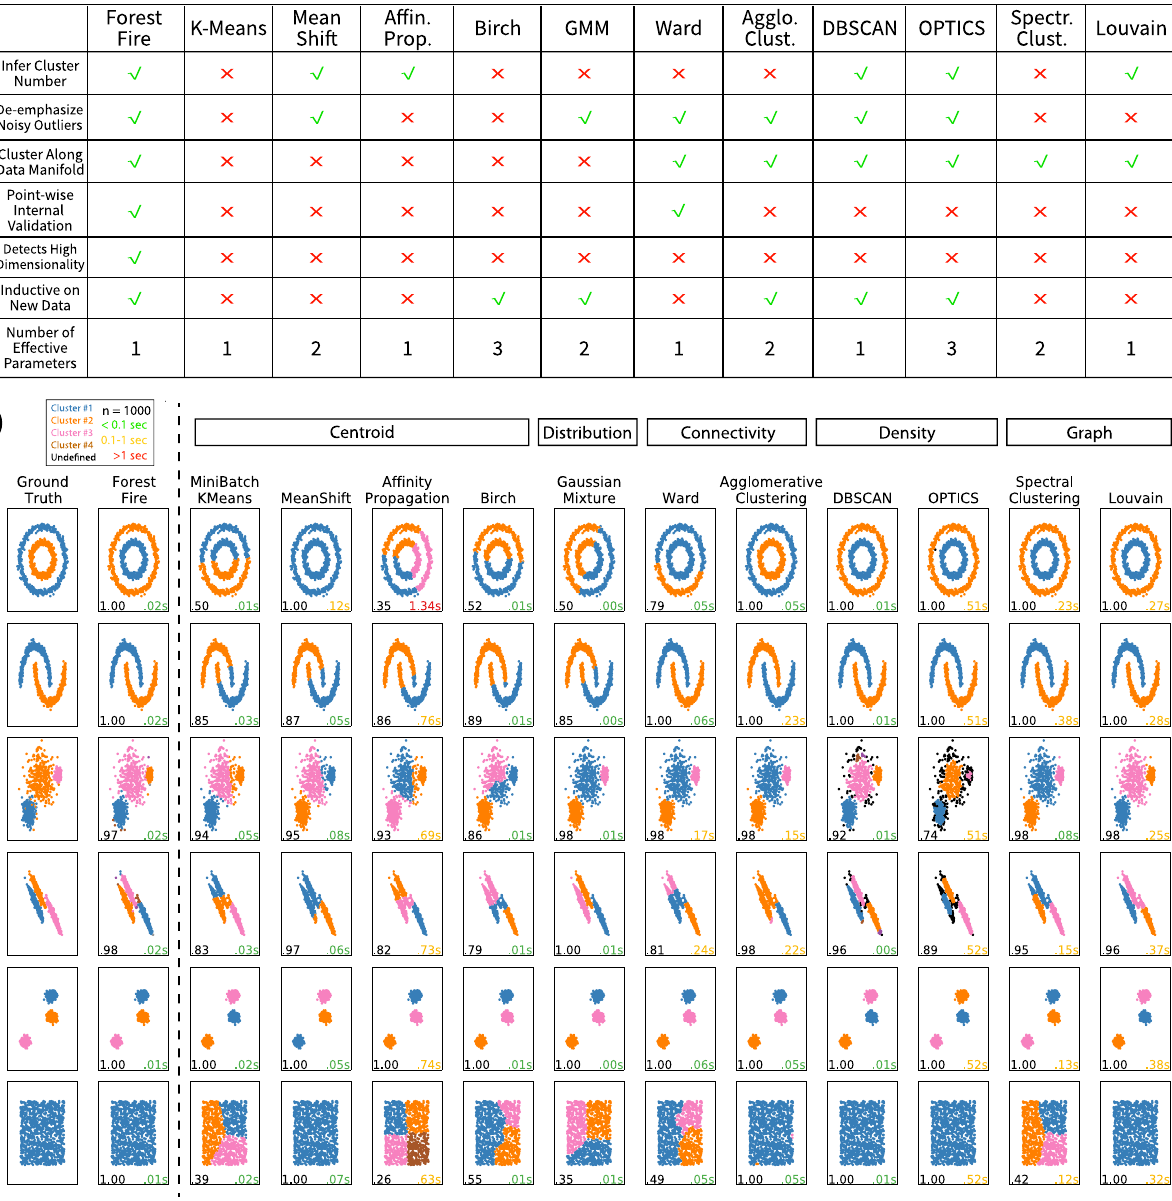
Fig. 3 Comparing Forest Fire Clustering with other clustering methods. a Table comparing features of Forest Fire Clustering with many existing clustering methods. b Benchmarking Forest Fire Clustering with other types of clustering methods on synthetic datasets ( n = 1000). The lower left denotes the purity score, and lower right records the runtime (green ≤ 0.1 s; yellow > 0.1 s and ≤ 1 s; red > 1